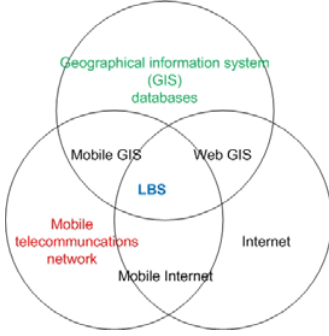
Figure 1. Location-Based Services (LBS) as intersection of three